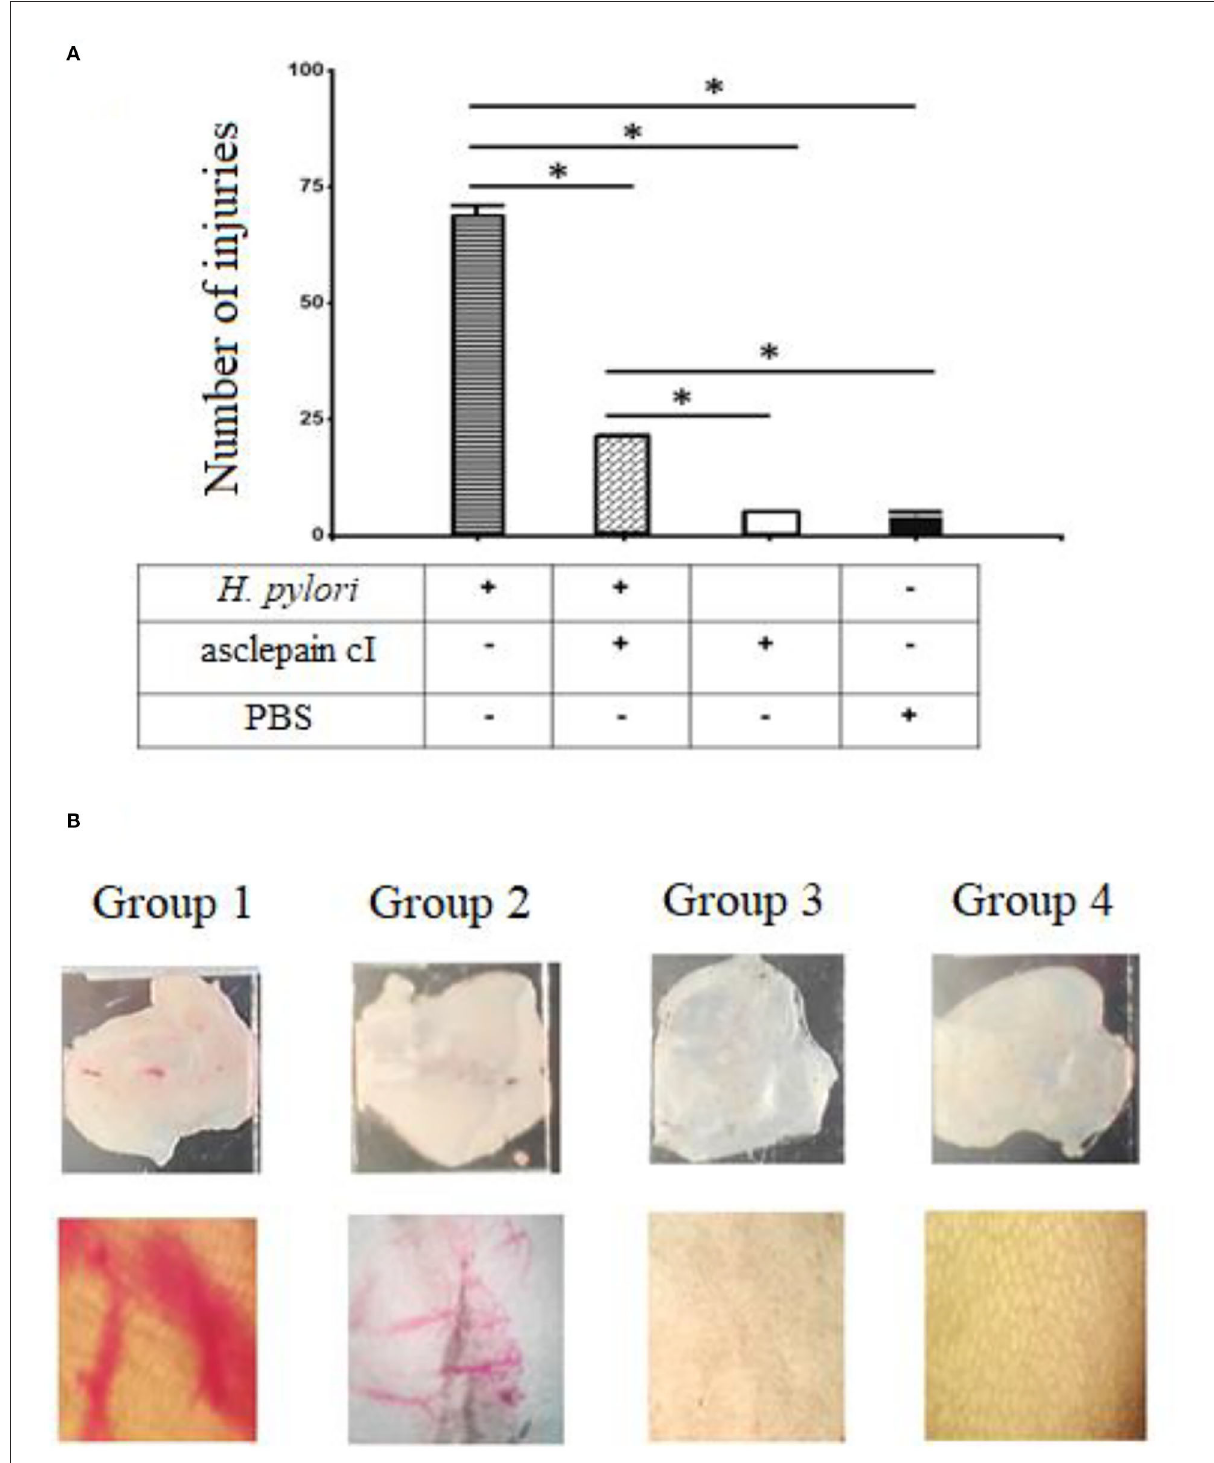
FIGURE4 (A,B) Gastroprotective effects of asclepain cI. Group 1: Stomach infected with H. pylori. Group 2: Stomach treated with asclepain cI and infected with H. pylori. Group 3: Stomach treated with asclepain cI. Group 4: Stomach treated with PBS (Control). The * symbol indicates the significant differences between groups (* p < 0.05). All values are expressed as mean ±